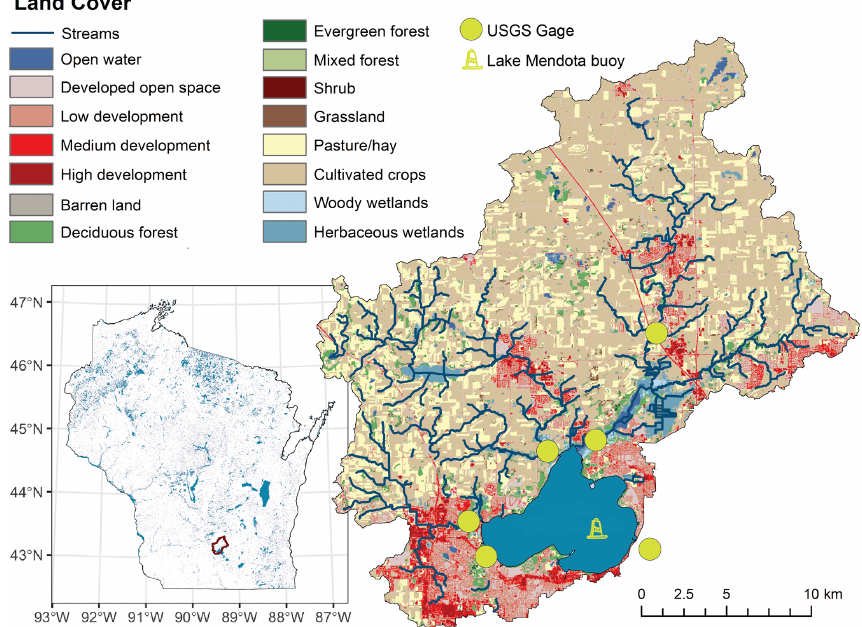
Figure 1. Location and overview map of Lake Mendota, Wisconsin, which is located in the Yahara River catchment in southern Wisconsin, USA. USGS gage stations for the PIHM-Lake model and the location of the Lake Mendota monitoring buoy are placed in the map. Land cover was sourced from the open-access US National Land Cover